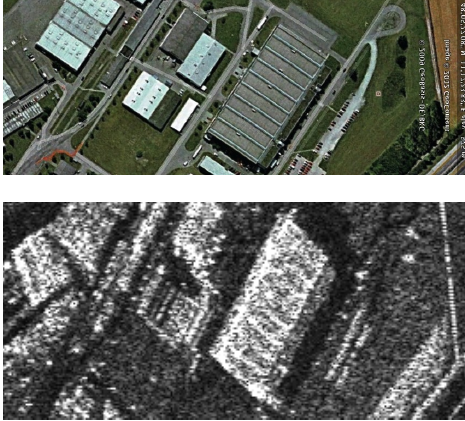
Figure 1: Optical image representing the test area (top), corre- sponding SAR intensity image